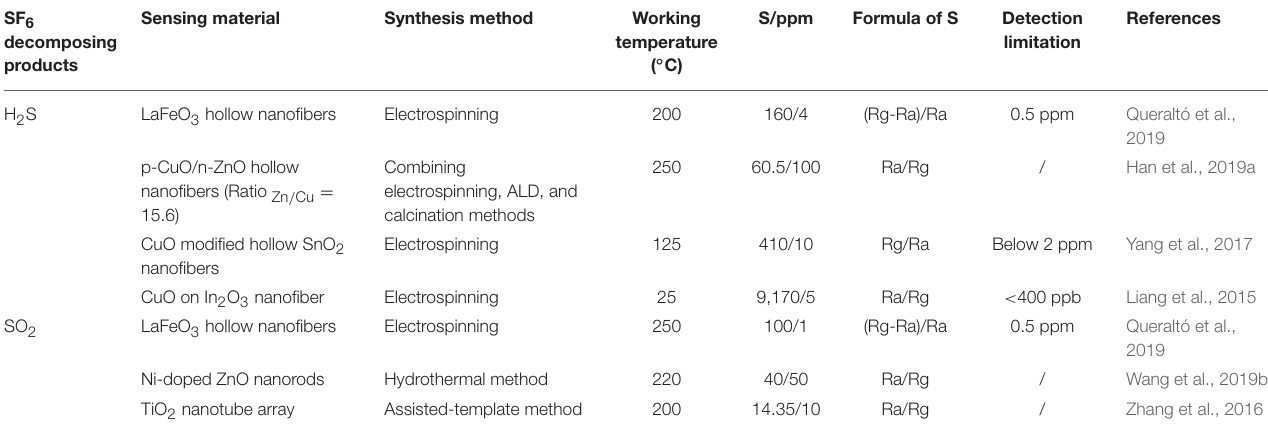
TABLE 1 | Comparison of the representative hollow nanofibers based sensors for H 2 S and SO 2 . SF 6